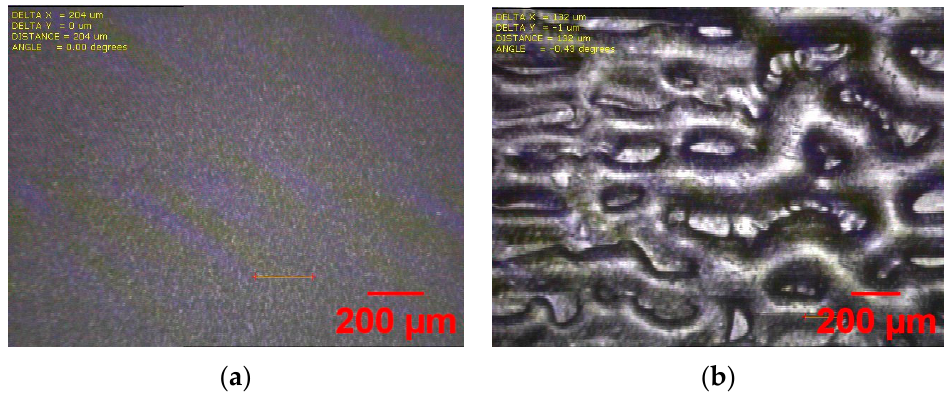
Figure 4. Microscope image of printed CNT source and drain, channel, and dielectric layer on Kapton with various concentrations of 2:1 cross-linked PVP ink and carrier gas pressure: ( a ) 2.5 wt.% solution with UA of 18 sccm; ( b ) 2.5 wt.% solution with UA of 22 sccm; ( c ) 5 wt.% solution with UA of 28 sccm.